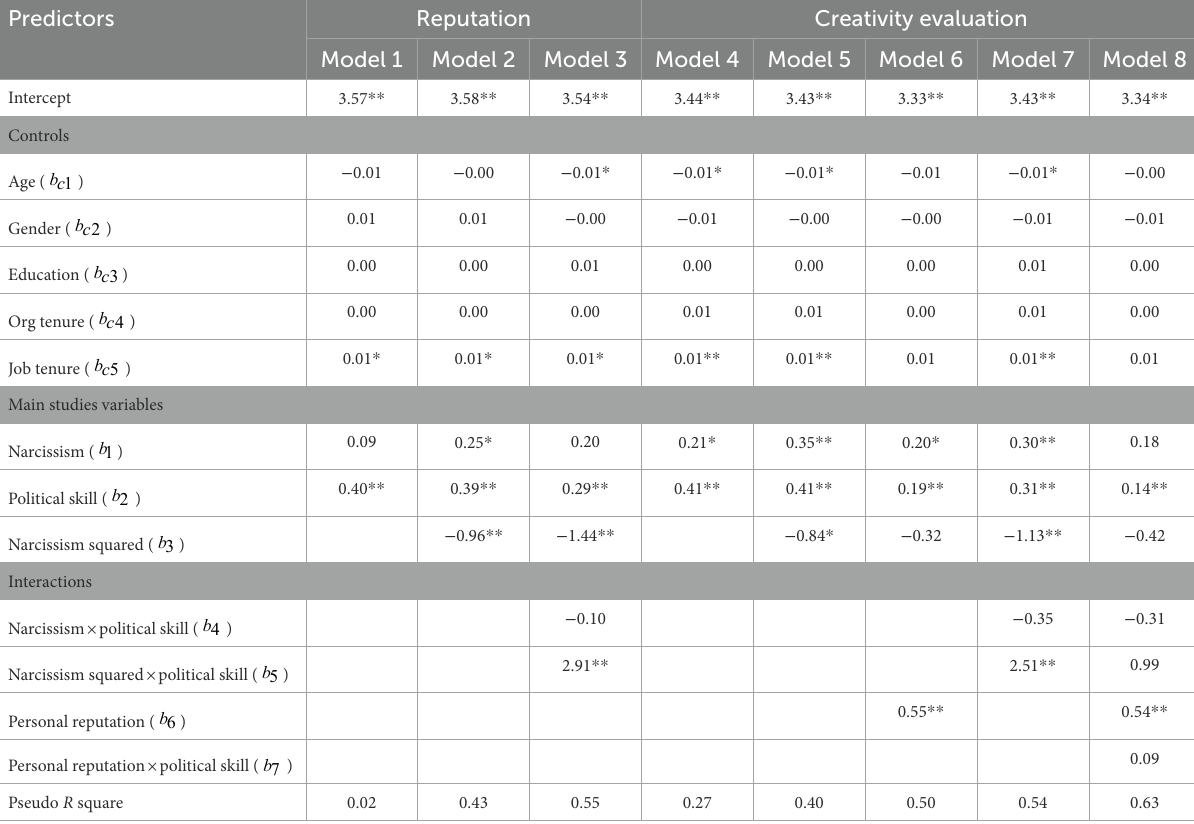
TABLE 2 Results of hierarchical linear modeling